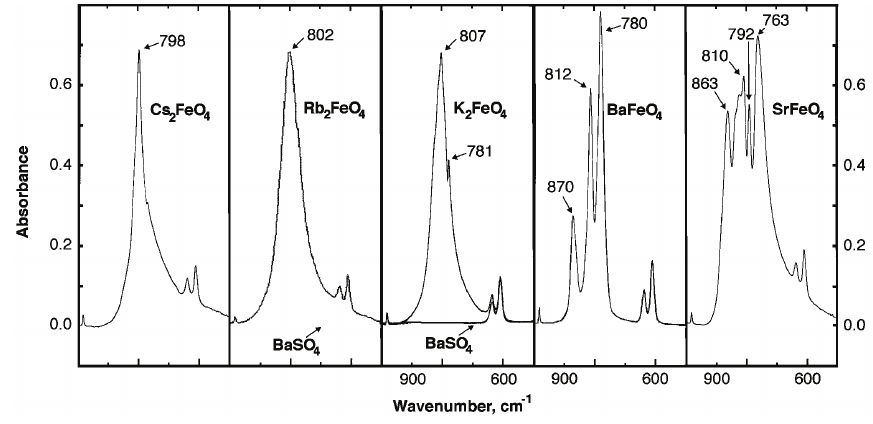
Figure 5. IR absorption of solid K with a BaSO charge transfer and analysis of Cs super-irons. J. Electrochem. Soc . 2004 , 151 , A1147–A1151.